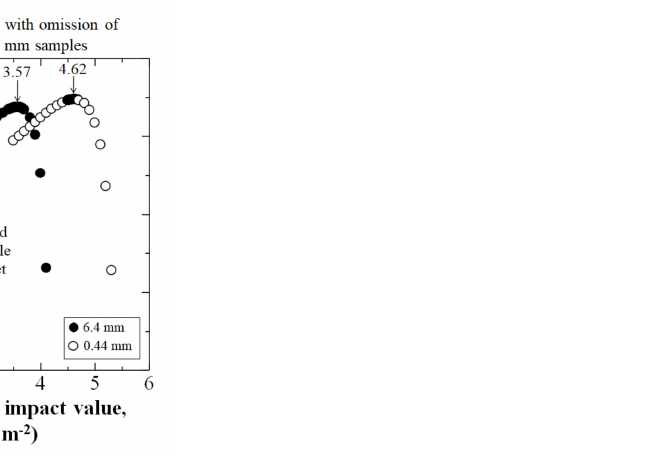
Figure 12. Iteration of potential impact value ( e a s ) to obtain the statistically lowest impact value a s at P f = 0 by 3-parameter Weibull analysis with the omission of the 2 lowest a uc 0.44 mm samples for the data in Figure